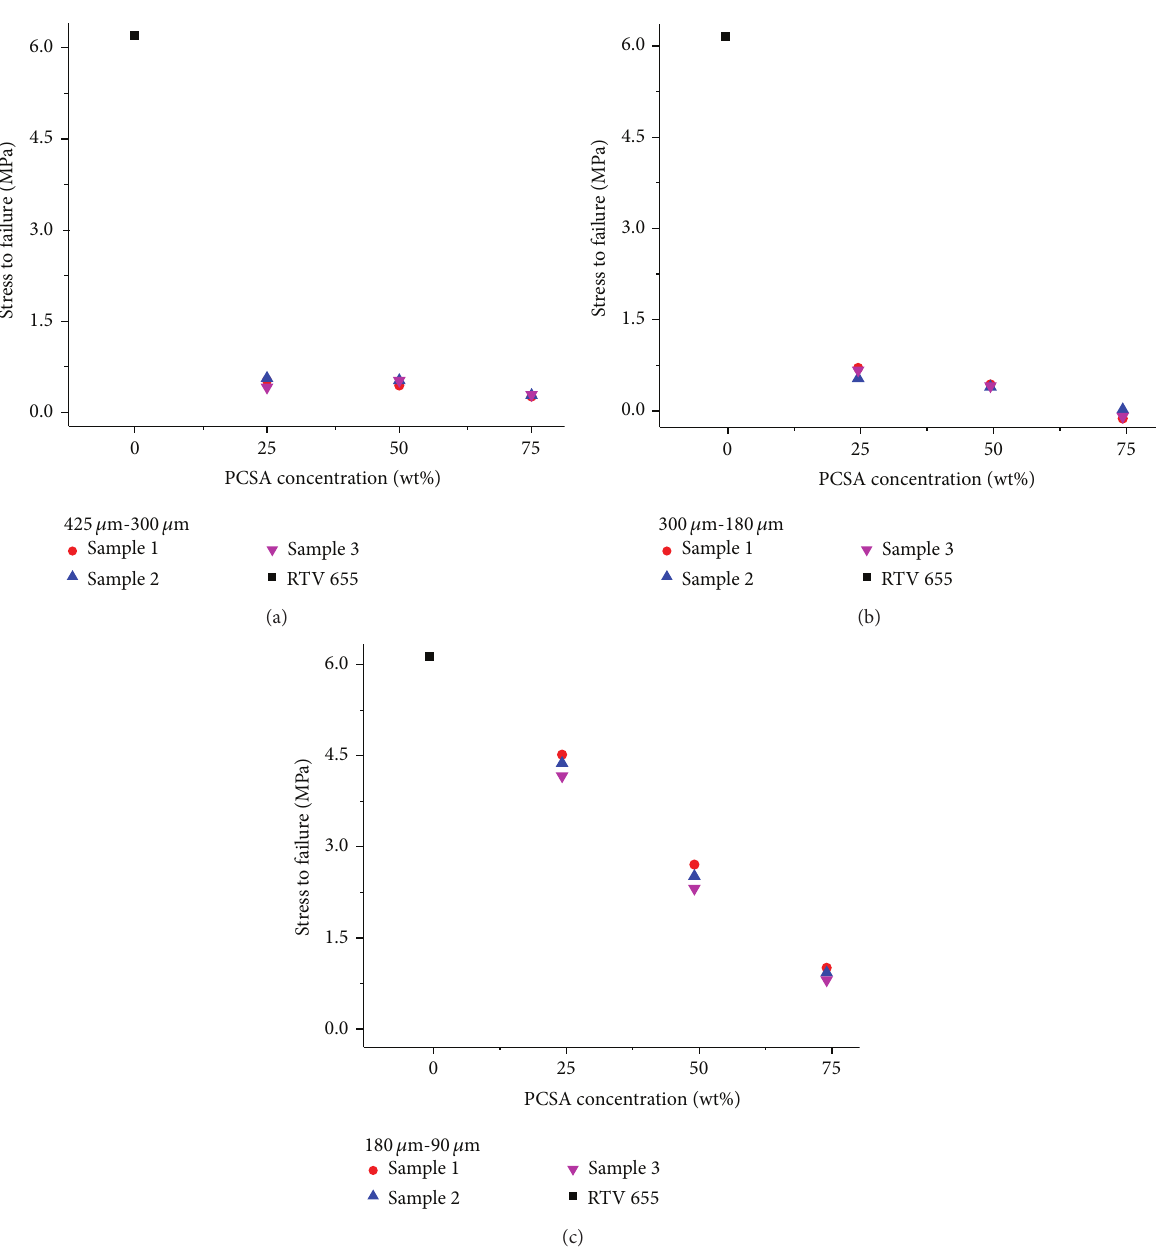
Figure 5: Comparison of the rupture load of RTV 655+PCSA compound specimens at room temperature with neat (0% IL) RTV 655 samples. Samples were impregnated with three particle size ranges: (a) 𝑑 1 = 300–425 𝜇 m, (b) 𝑑 2 = 180–300 𝜇 m, and (c) 𝑑 3 = 90–180 𝜇 m measured for three separate sample batches. A trend of reduction in the overall mechanical strength of compound material was observed due to incorporation of PCSA particles. However, a least amount of reduction in the yield strength of the compound sample was observed at 25 wt. (%) impregnation with the smallest ( 𝑑 3 = 90–180 𝜇 m) PCSA